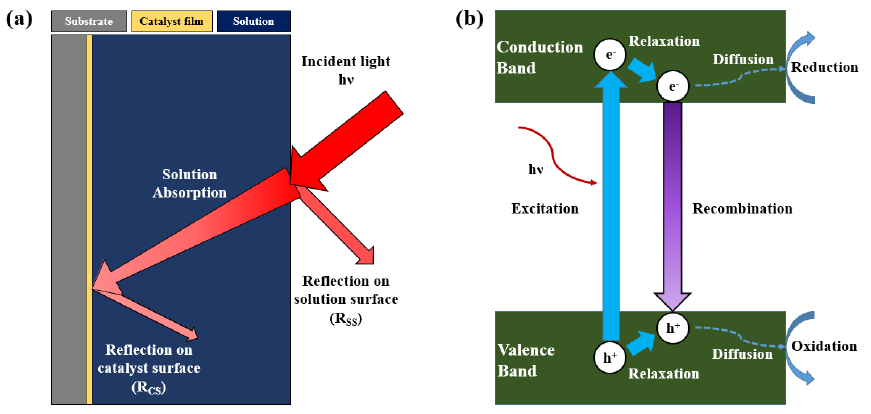
Figure 1. ( a ) Light loss in a photocatalytic water treatment process and ( b ) the recombination of photogenerated electron and hole in a typical photocatalytic